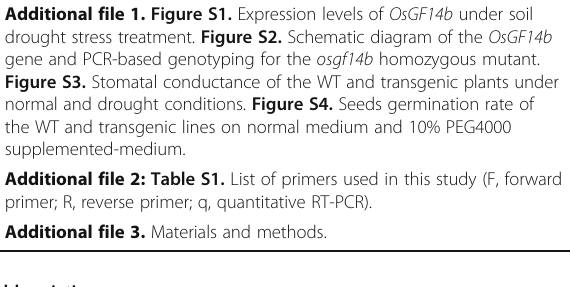
Additional file 1. Figure S1. Expression levels of OsGF14b under soil drought stress treatment. Figure S2. Schematic diagram of the OsGF14b gene and PCR-based genotyping for the osgf14b homozygous mutant. Figure S3. Stomatal conductance of the WT and transgenic plants under normal and drought conditions. Figure S4. Seeds germination rate of the WT and transgenic lines on normal medium and 10% PEG4000